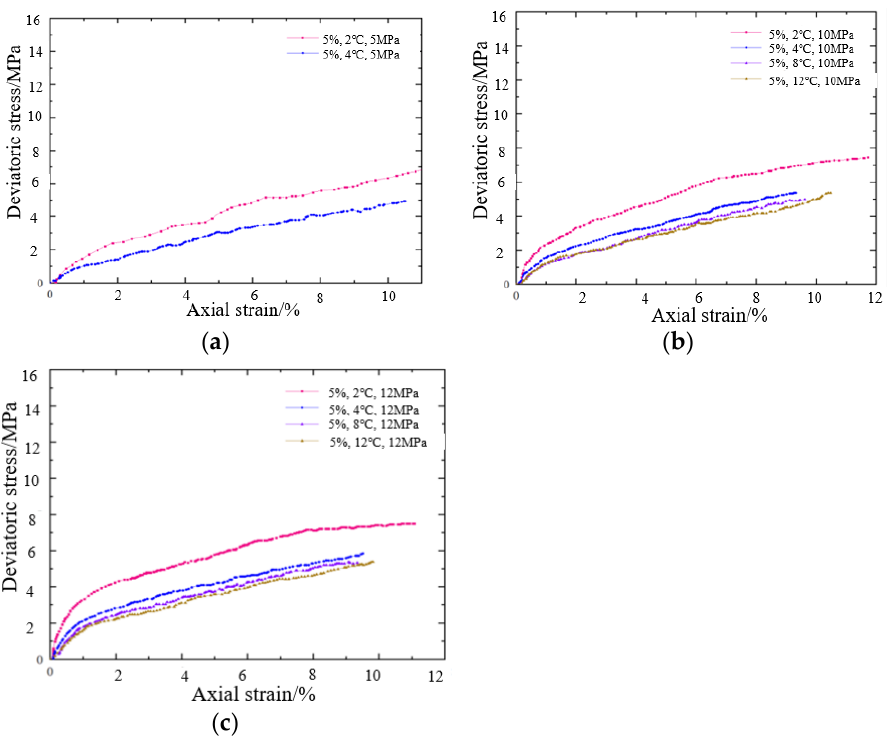
Figure 10. Core stress–strain curves at different temperatures (saturation 5%) ( a ) The test pressure is 5 MPa; ( b ) The test pressure is 10 MPa; ( c ) The test pressure is 12 MPa.